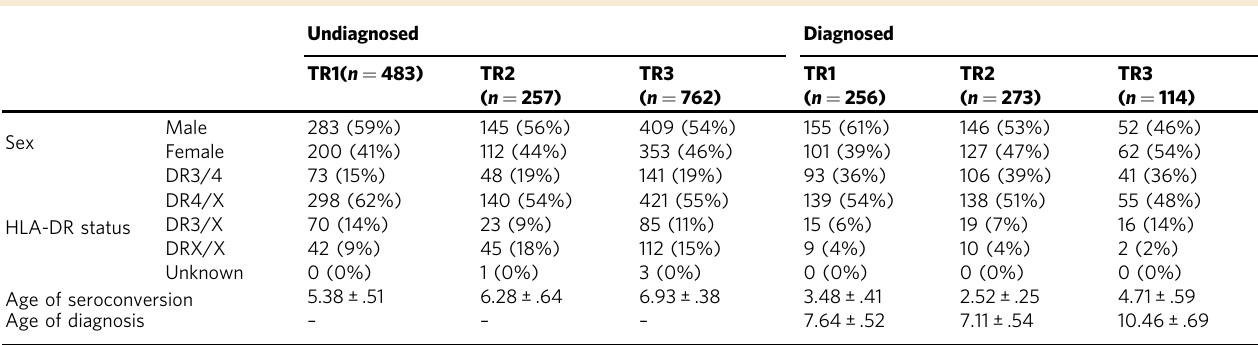
fi rst IAb positive state (3.75 years). Of note, for TR1-1, there was no difference in survival rates between participants entering the multiple islet autoantibody states before or after the overall median age of entry into fi rst IA positive state ( Z 2 (1) = 1.6, p = 0.2) (Fig. 5a). In contrast, participants who entered the fi rst islet autoantibody positive states in TR2 and TR3 did show differences in survival rates by age. Participants entering IAA positive state